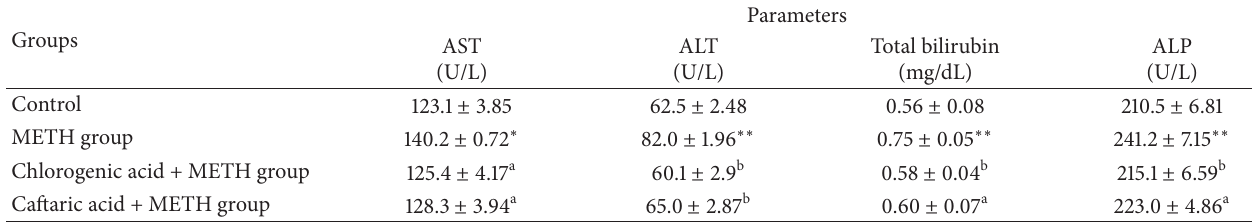
Table 1: Effect of chlorogenic and caftaric acids on serums AST, ALT, total bilirubin, and ALP of METH-injected rats.